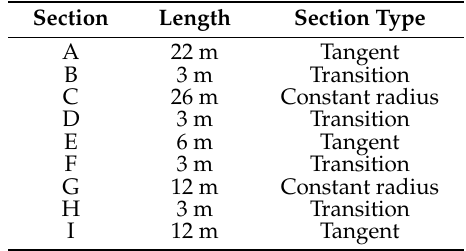
Table 1. Experimental scaled track ideal geometry.